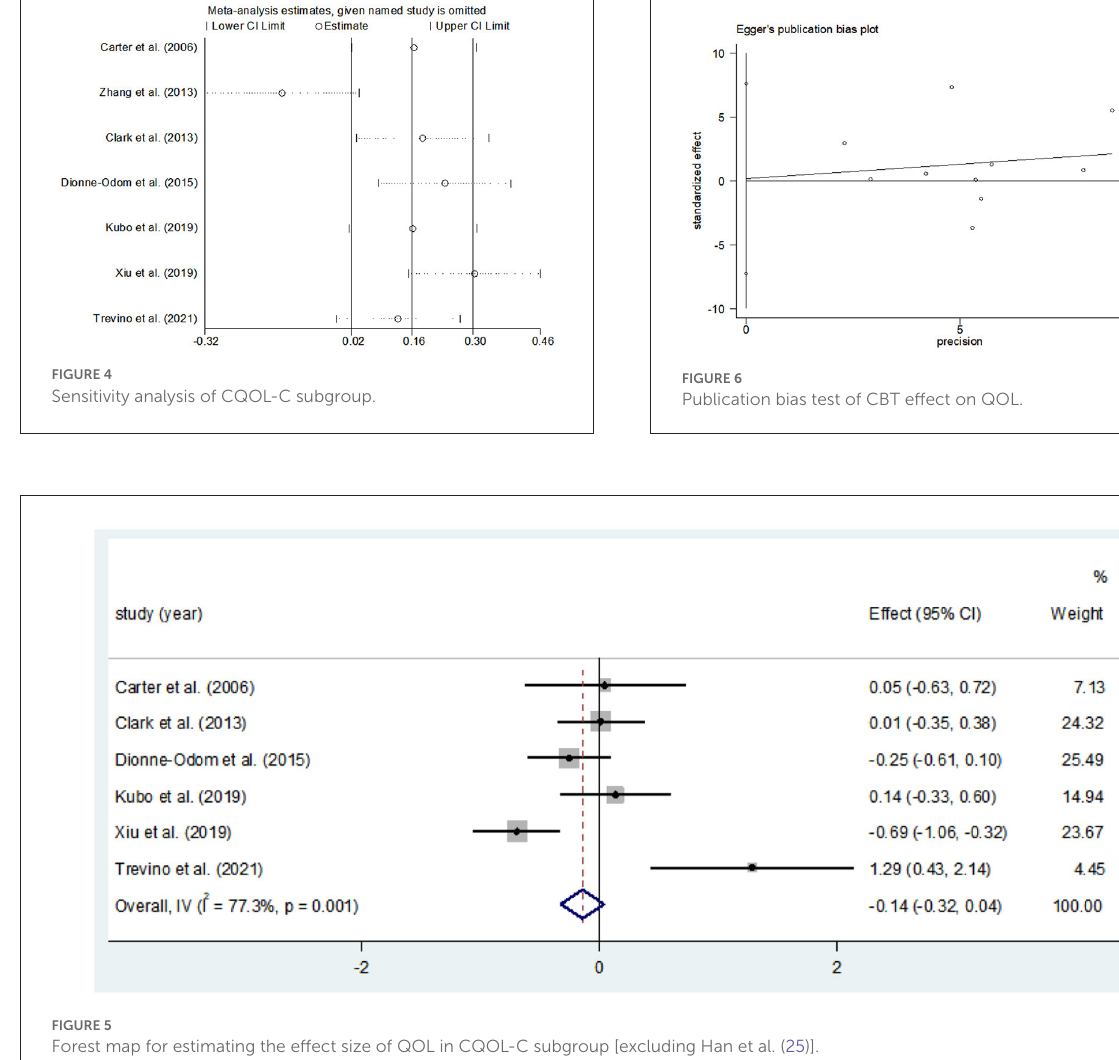
FrontiersinPsychiatry